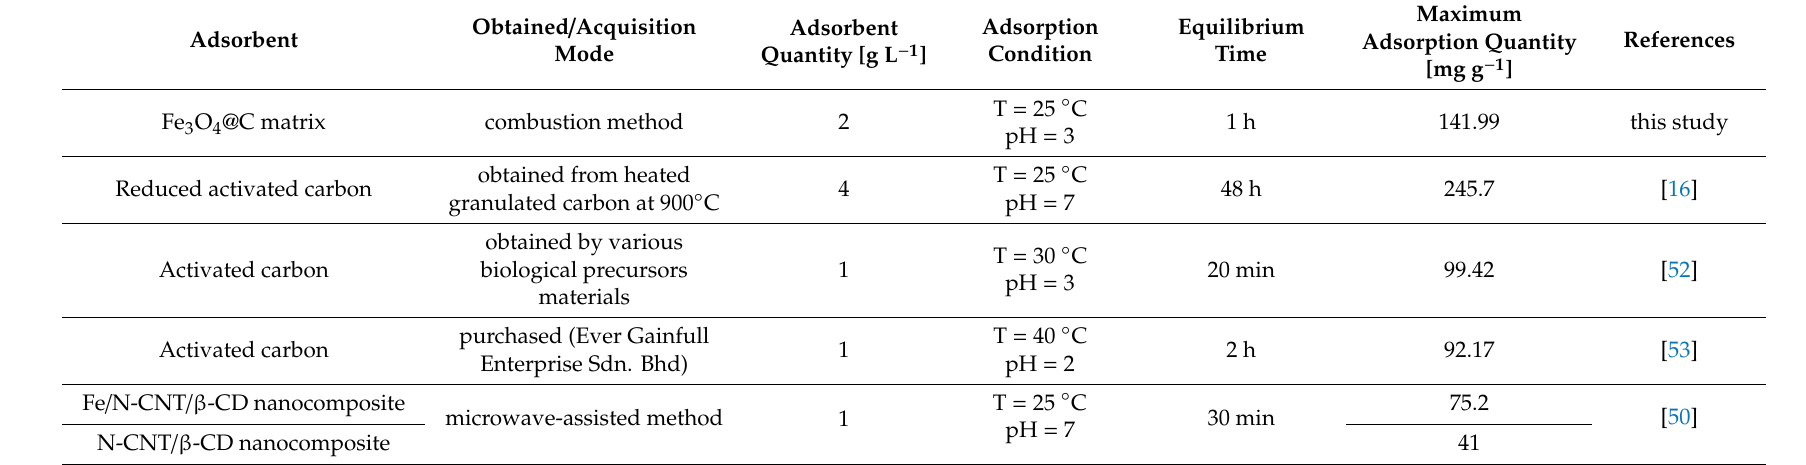
Table 4. Comparison of the removal e ffi ciency of paracetamol using di ff erent adsorbents.